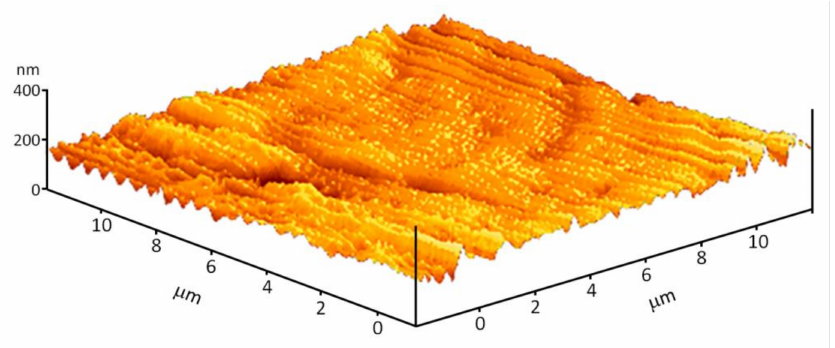
Figure 6. Reconstruction of the surface of the AP-ZnO material using atomic force